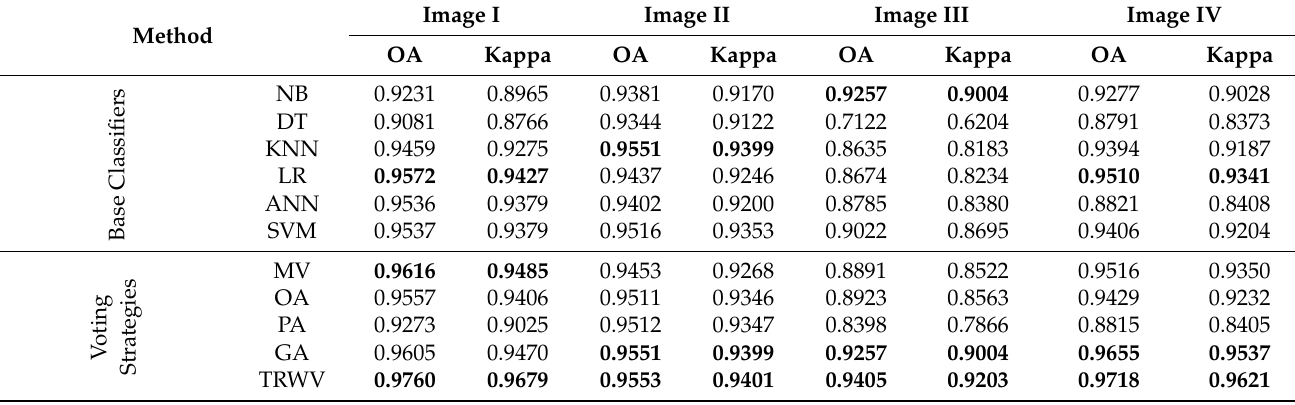
Table 6. The OA and kappa coefficients for the base classifiers and the ensemble classifiers with different voting strategies on four scenes of the testing